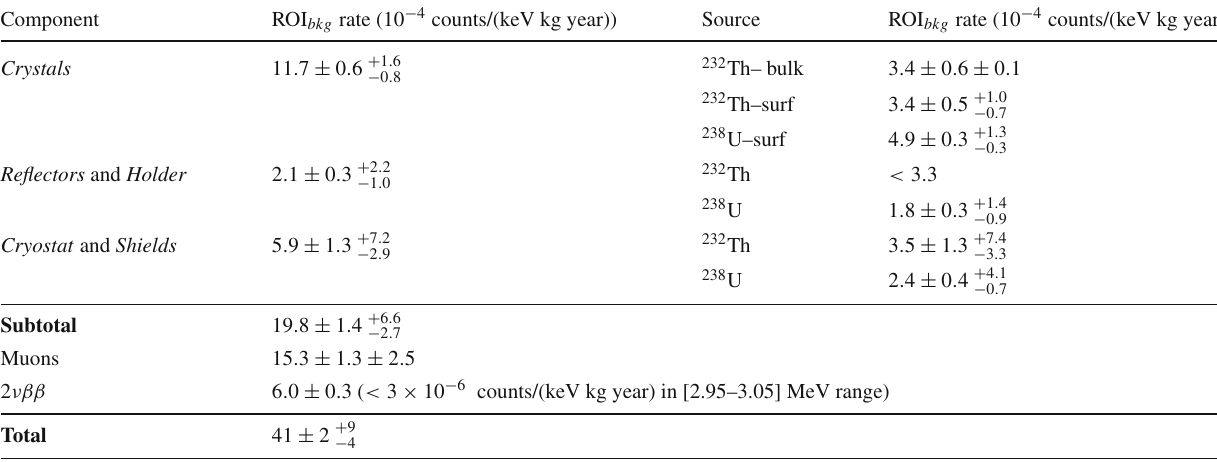
Table 5 Counting rates reconstructed in the ROI bkg (from 2.8 to 3.2 MeV) for the different sources, after applying the time veto for the rejection of 208 Tl events. For each value of counting rate we quote first the statistical uncertainty and then the systematic one. In the left column we report the total counting rates from the different compo- nents of the experimental setup, while in the right column we provide their breakdown by source. 232 Th and 238 U refers the chain parts pro-